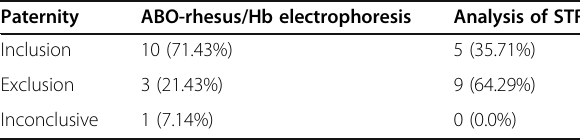
Table 4 Inclusion and exclusion with the ABO-rhesus/ hemoglobin electrophoresis and analysis of STR Paternity ABO-rhesus/Hb electrophoresis Analysis of STR Inclusion 10 (71.43%) 5 (35.71%) Exclusion Inconclusive Legend: STR Short Tandem Repeat, Hb